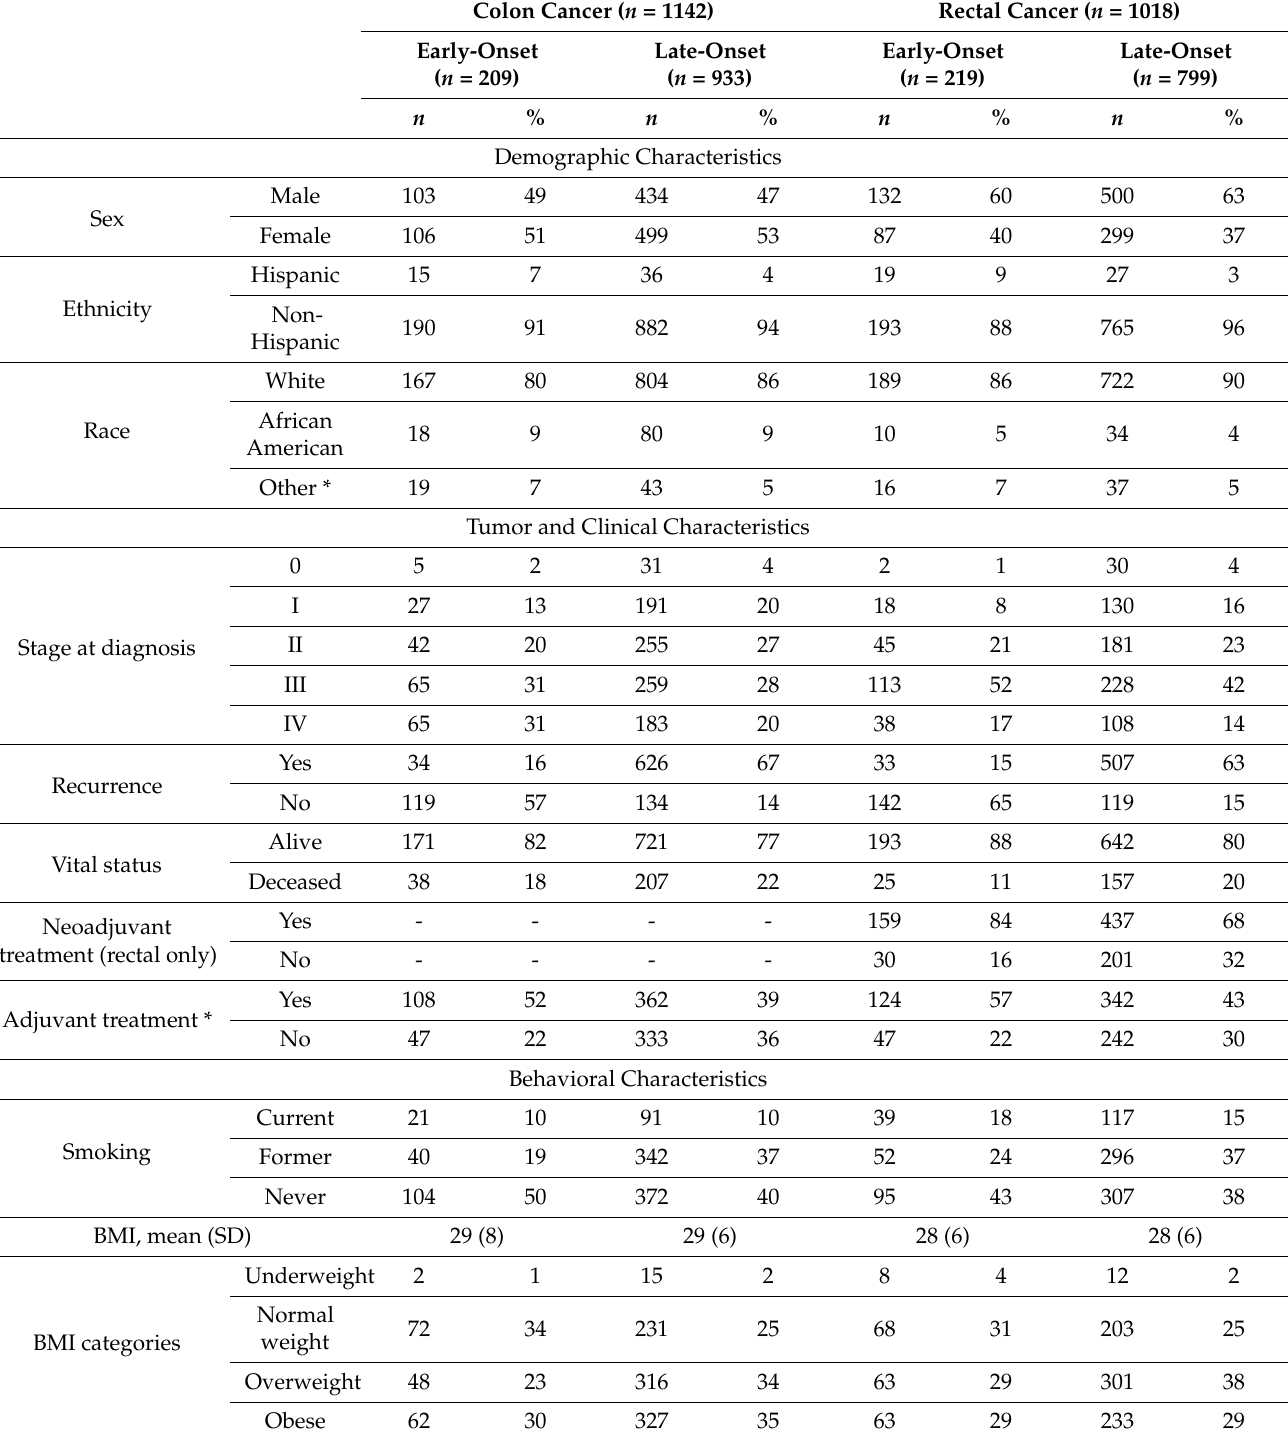
Table 2. Frequencies and percentages of patient, tumor, and behavior characteristics by tumor site and age of onset A